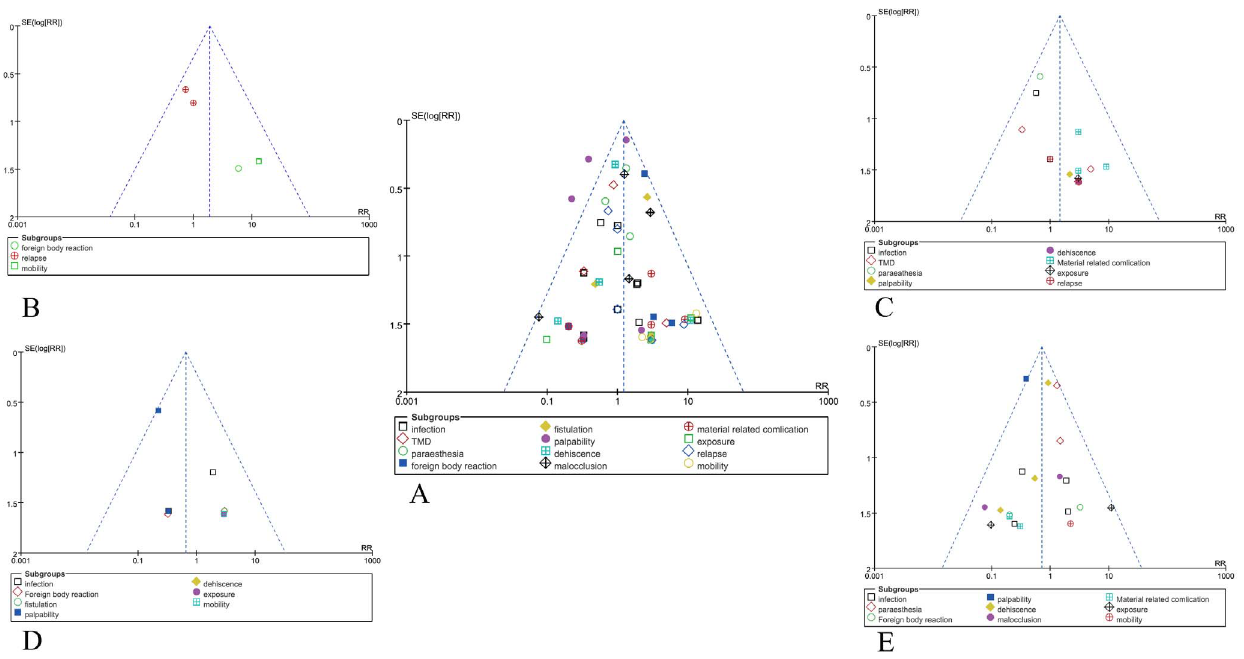
Figure 3. Funnel plot to assess for evidence of publication bias. 3a. Funnel plot for the complication in all studies; 3b. Funnel plot for the complication in bimaxillary operations; 3c. Funnel plot for the complication in BSSRO; 3d. Funnel plot for the complication in Le Fort I; 3e. Funnel plot for the complication in fracture fixation.